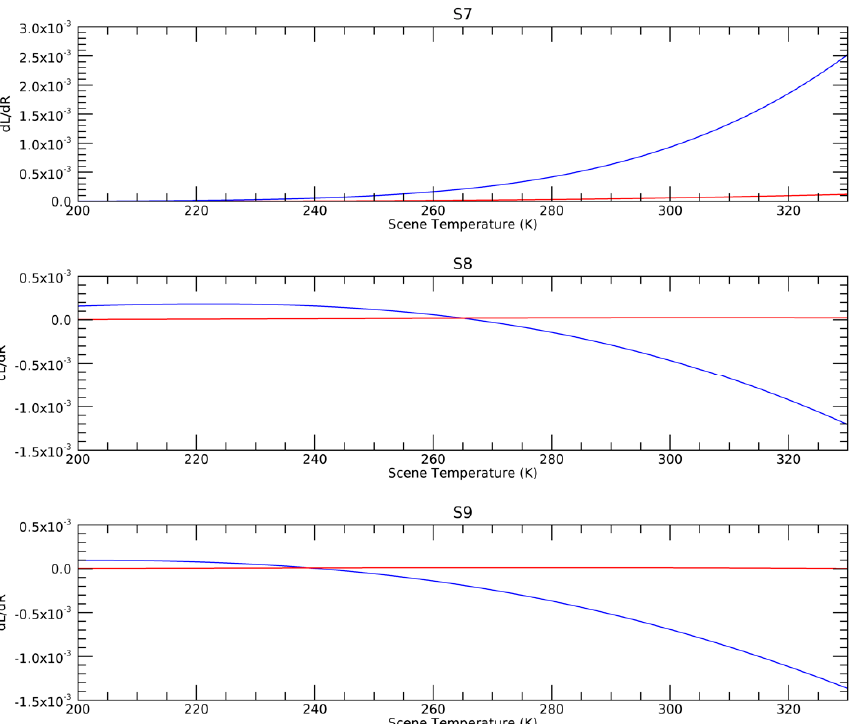
Figure 8. Sensitivity coefficient dL / dR ( λ ) for spectral radiance errors in Wm − 2 sr − 1 µ m − 1 /nm due to uncertainty in spectral band-centre (blue line) and uncertainty in bandwidth (red line).